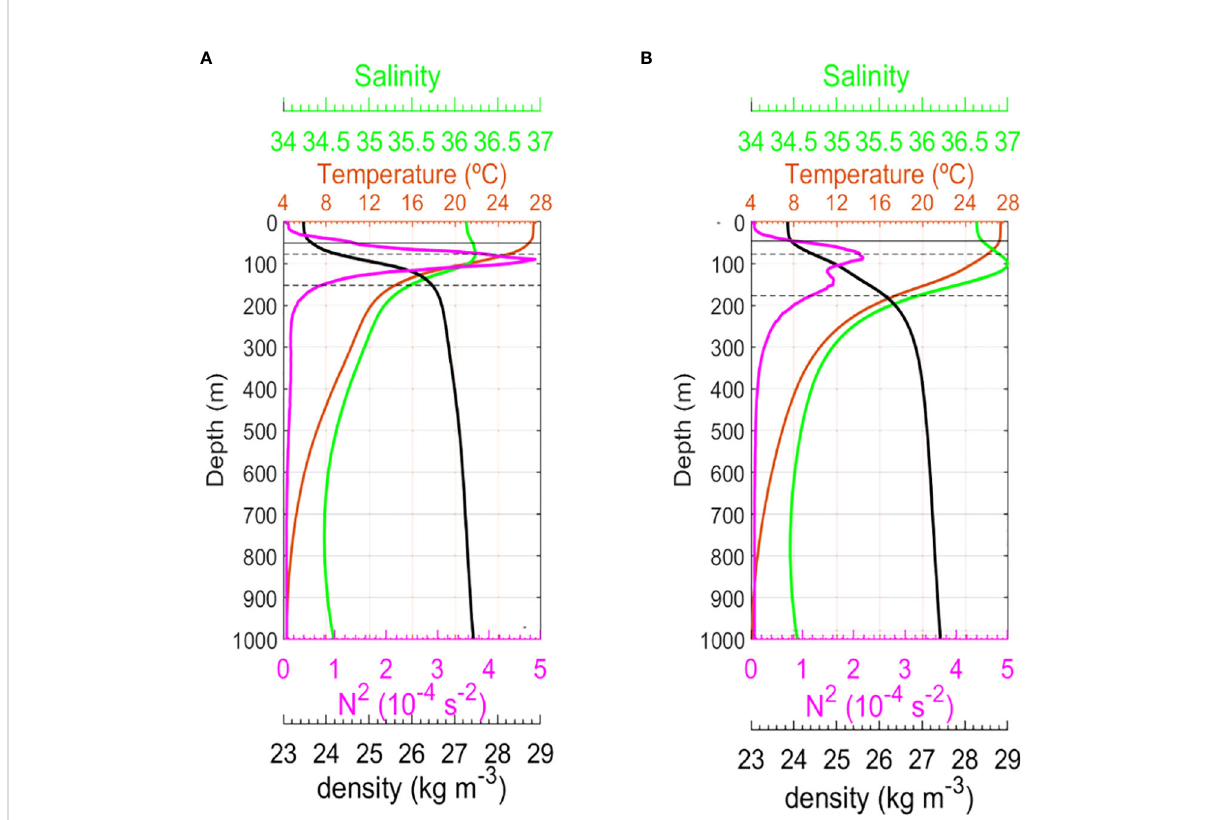
FIGURE 12 Mean Temperature, salinity, density, and squared buoyancy frequency (N 2 ) inside eddies in the regions (A, B) Solid horizontal line indicates the base of the mixed layer depth while the dashed horizontals lines indicate the upper and lower thermocline depth. The lower thermocline depth also corresponds to the pycnocline depth.